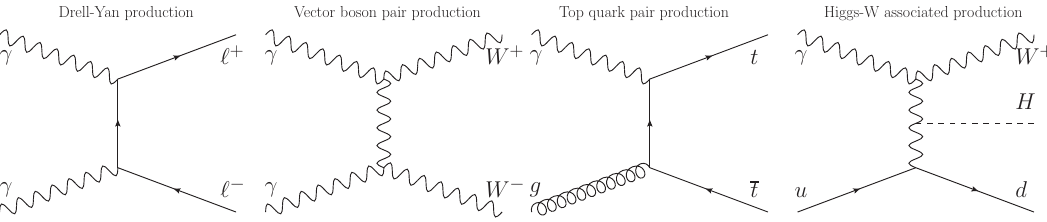
Figure 4.1: Representative PI diagrams for various LHC processes: Drell-Yan, vector-boson pair production, top-quark pair production, and the associated production of a Higgs with a W